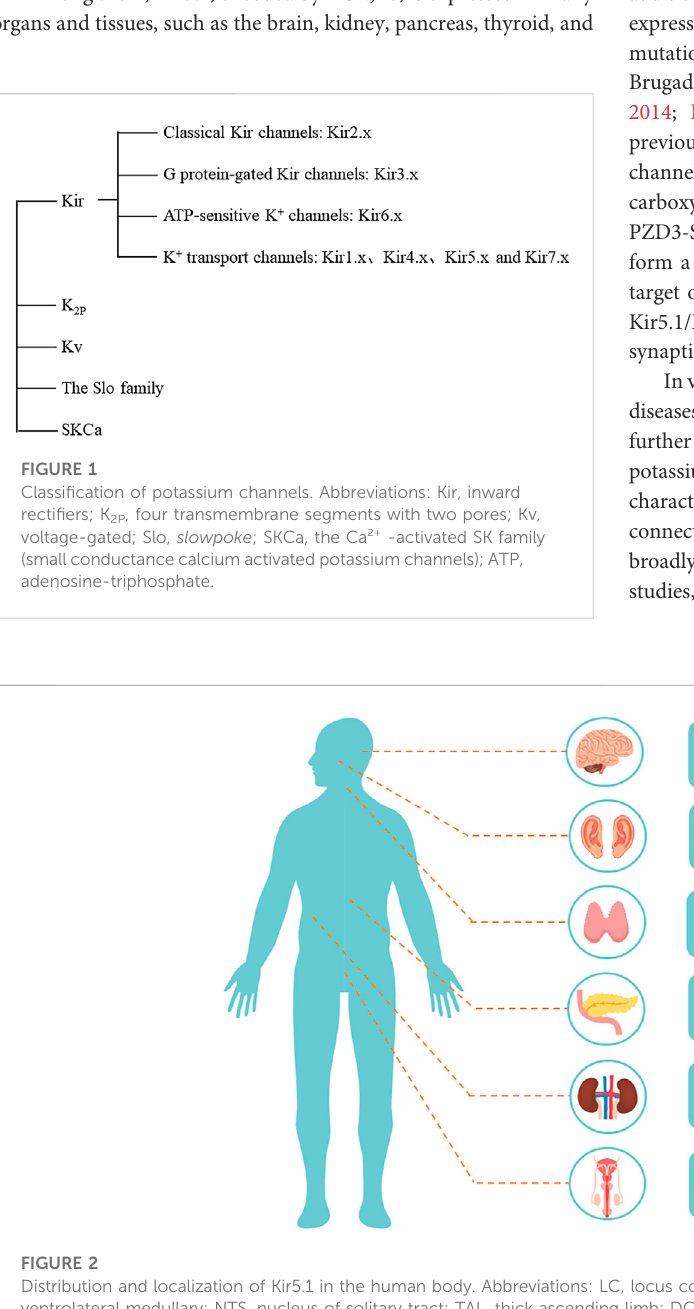
Distribution and localization of Kir5.1 in the human body. Abbreviations: LC, locus coeruleus; PBKF, parabrachial, and Kolliker-Fuse; VLM, ventrolateral medullary; NTS, nucleus of solitary tract; TAL, thick ascending limb; DCT, distal convoluted tubule; CCD, cortical collecting